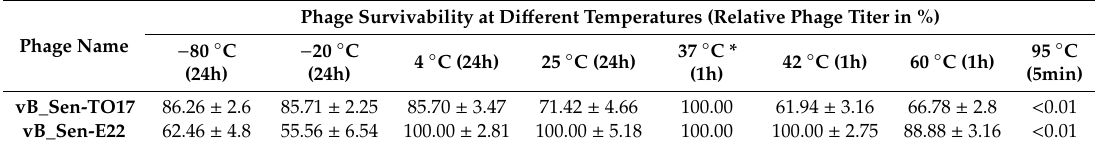
Table 5. Survivability of phages vB_Sen-TO17 and vB_Sen-E22 at di ff erent temperatures.